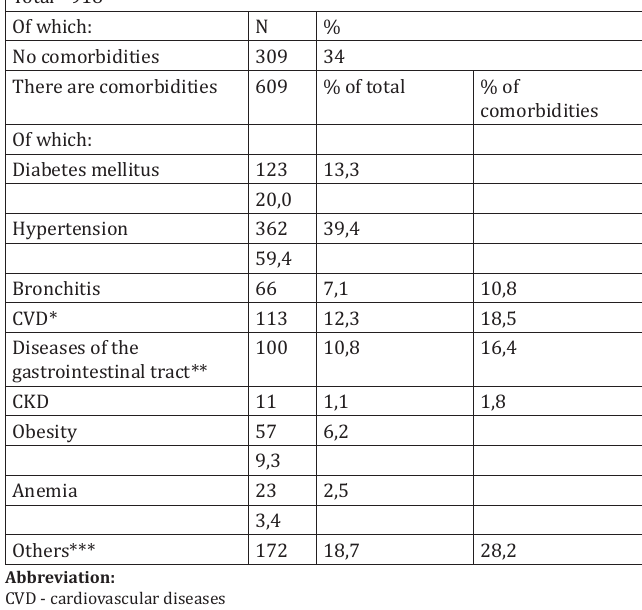
Characteristics of patients with COVID-19 Parameters